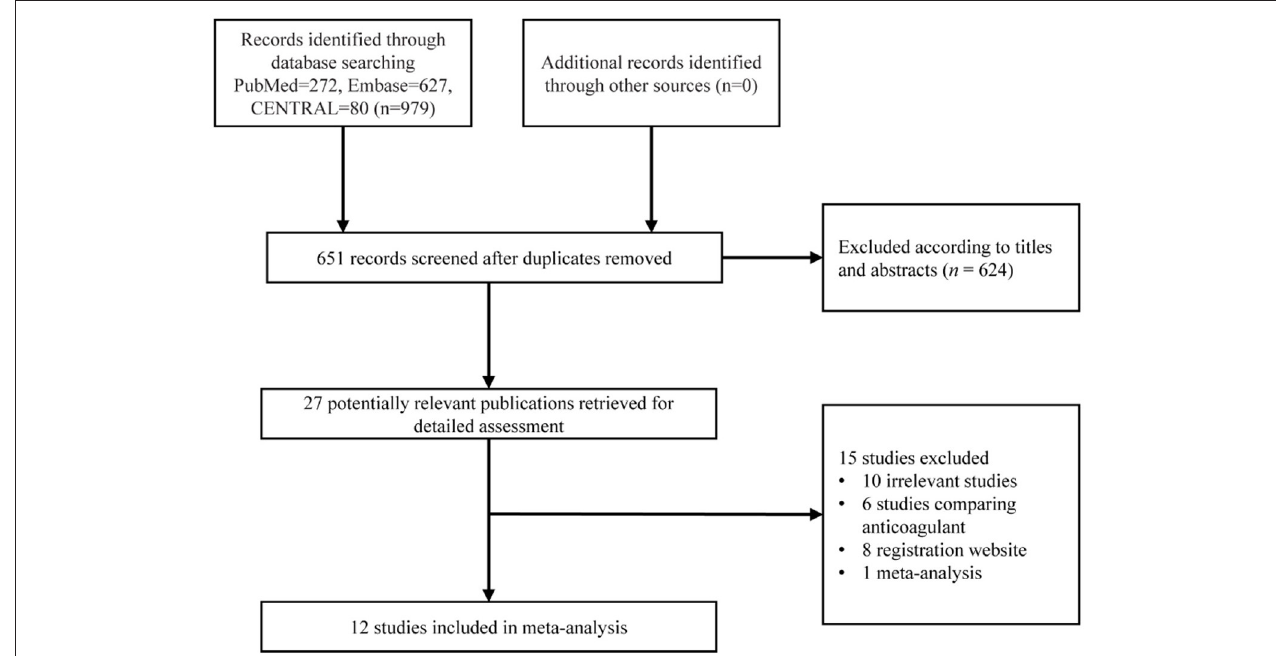
FIGURE 1 | Study flow chart of the search strategy and selection process for